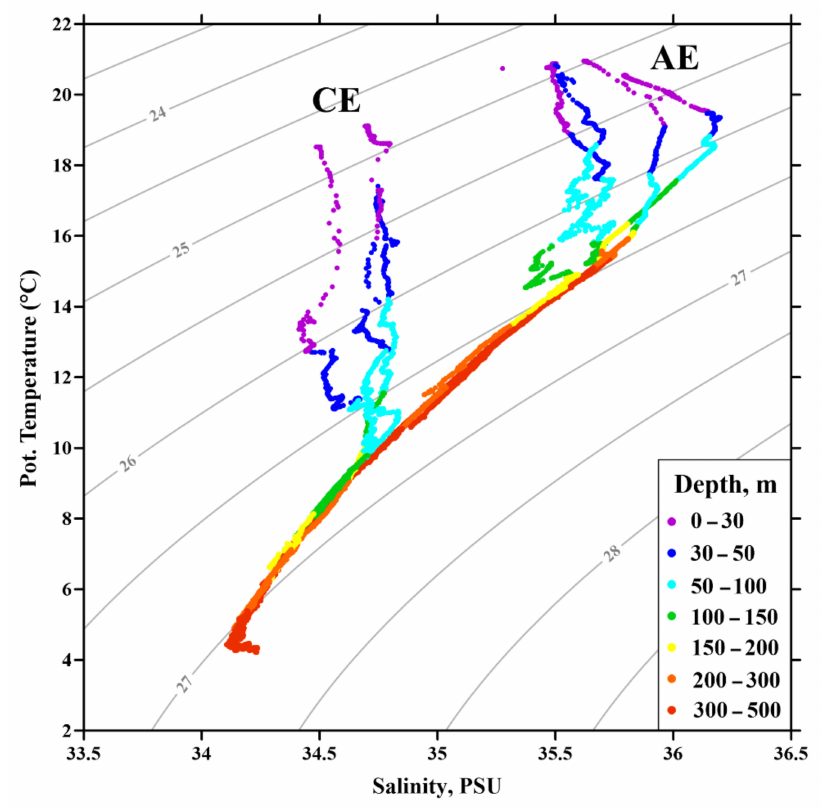
Figure 4. θ ,S-diagram based on data from seven stations through an eddy dipole. The depth of measurements is shown with colors. CE is cyclonic eddy; AE is anticyclonic